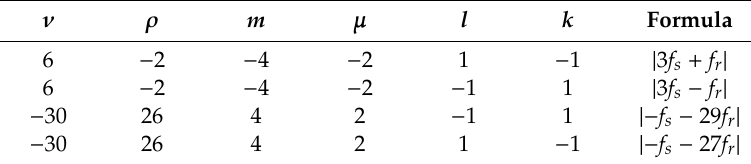
Table 6. Harmonic orders and formulas for the mixed eccentricity case.